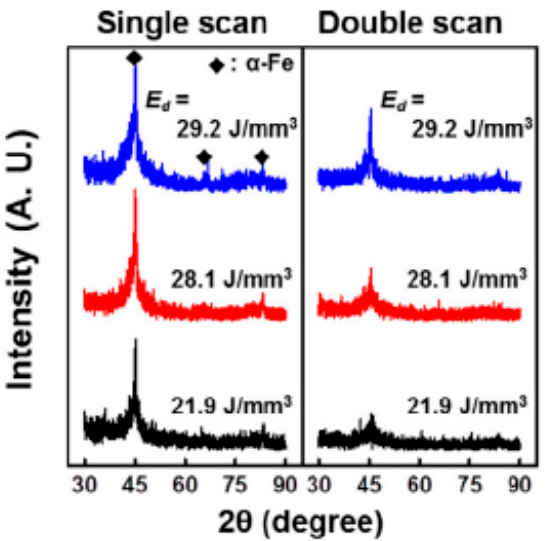
Figure 14. X-ray powder diffraction (XRD) patterns of 3D-printed Fe 73.7 Si 11 B 11 C 2 Cr 2.28 alloys with different laser energy density (reprinted with the permission from [75], Elsevier, 2020).